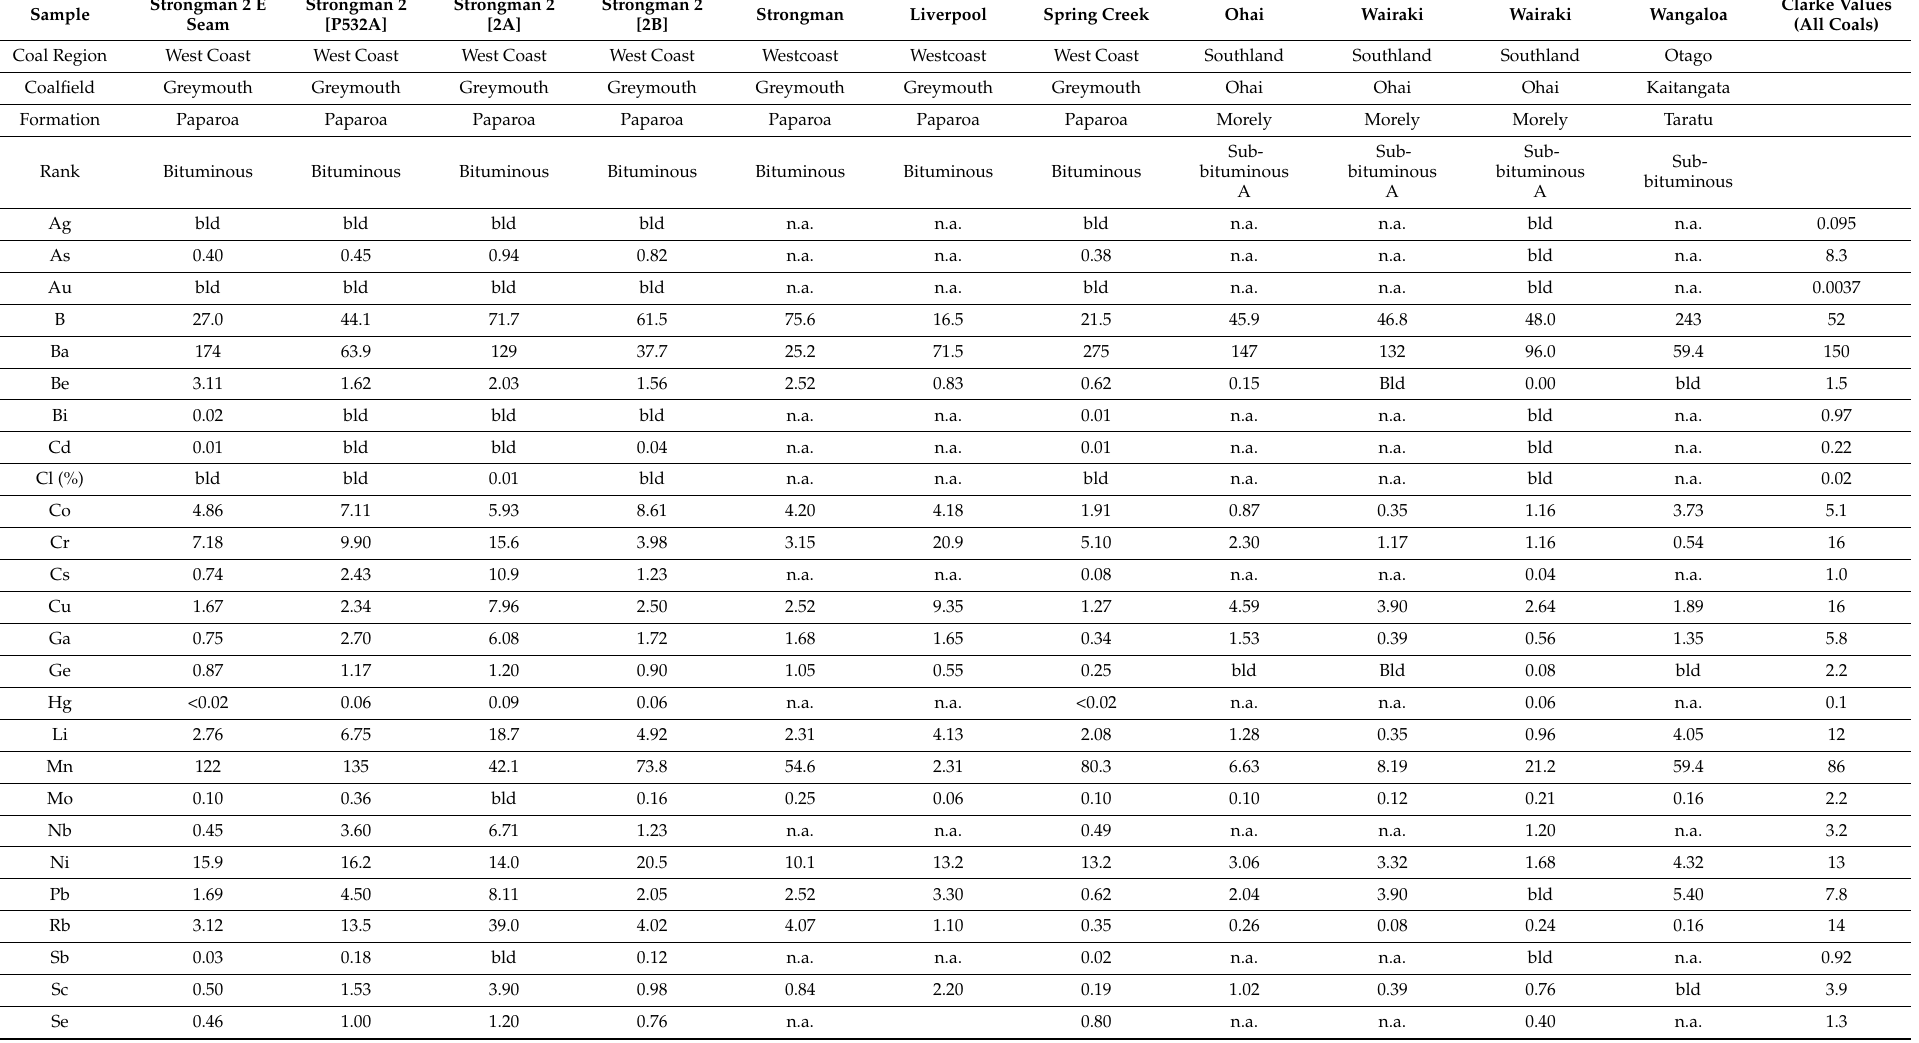
Table 9. Trace element concentrations in some New Zealand Cretaceous coals (after Soong and Berrow [164] and Moore et al.